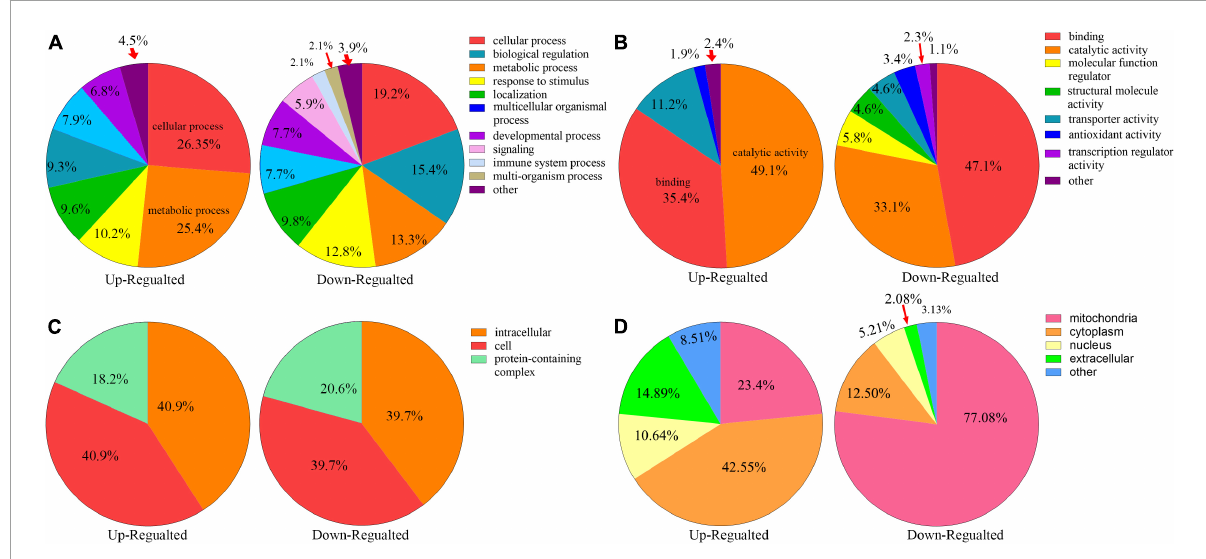
FIGURE4 Functional classifications of different lysine β -hydroxybutyrylation (kbhb) proteins in heart tissue of diabetic cardiomyopathy (DCM) rats. (A) Classification of kbhb proteins according to their biological processes (BPs). (B) Classification of kbhb proteins based on their molecular functions (MF). (C) Classification of kbhb proteins according to their cellular components (CC). (D) Analysis of the subcellular localization of the kbhb proteins.